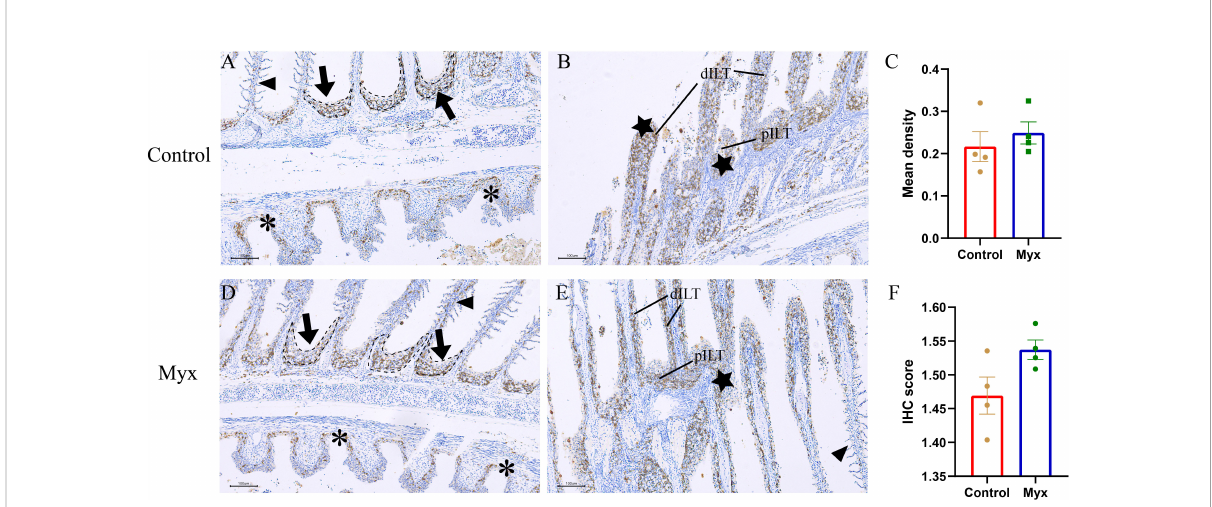
FIGURE 9 Representative immuno fl uorescent images of gills which were stained with Zap-70 + (brown). (A, B) Immunohistochemical analysis of gold fi sh in control group: (A) A few Zap-70 + cells appeared on ALT (black dotted line, black arrow), gill arch (*), and gill fi lament (black triangle). (B) Plentiful Zap-70 + cells appeared on distal ILT (dILT) and proximal ILT (pILT) ( ★ ). (C) Statistical analysis of mean optical density. (D, E) Immunohistochemical analysis of gold fi sh in Myx group: (D) A small number of ZAP-70 + cells were distributed in ALT (black dotted line, black arrow), gill arch (*), and gill fi lament (black triangle). (E) Plentiful Zap-70 + cells appeared on ILT ( ★ ). (F) Statistical analysis of IHC score. Signi fi cance: P < 0.05 (*), P < 0.01 (**), P < 0.001 (***). (n=4).